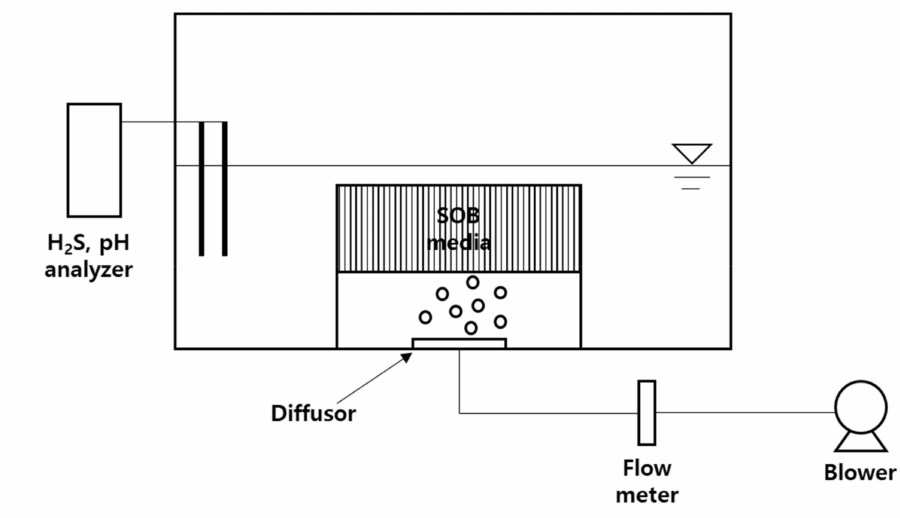
Figure 1. Schematic diagram of the experimental setup for sulfur-oxidizing bacteria (SOB) media in laboratory-scale